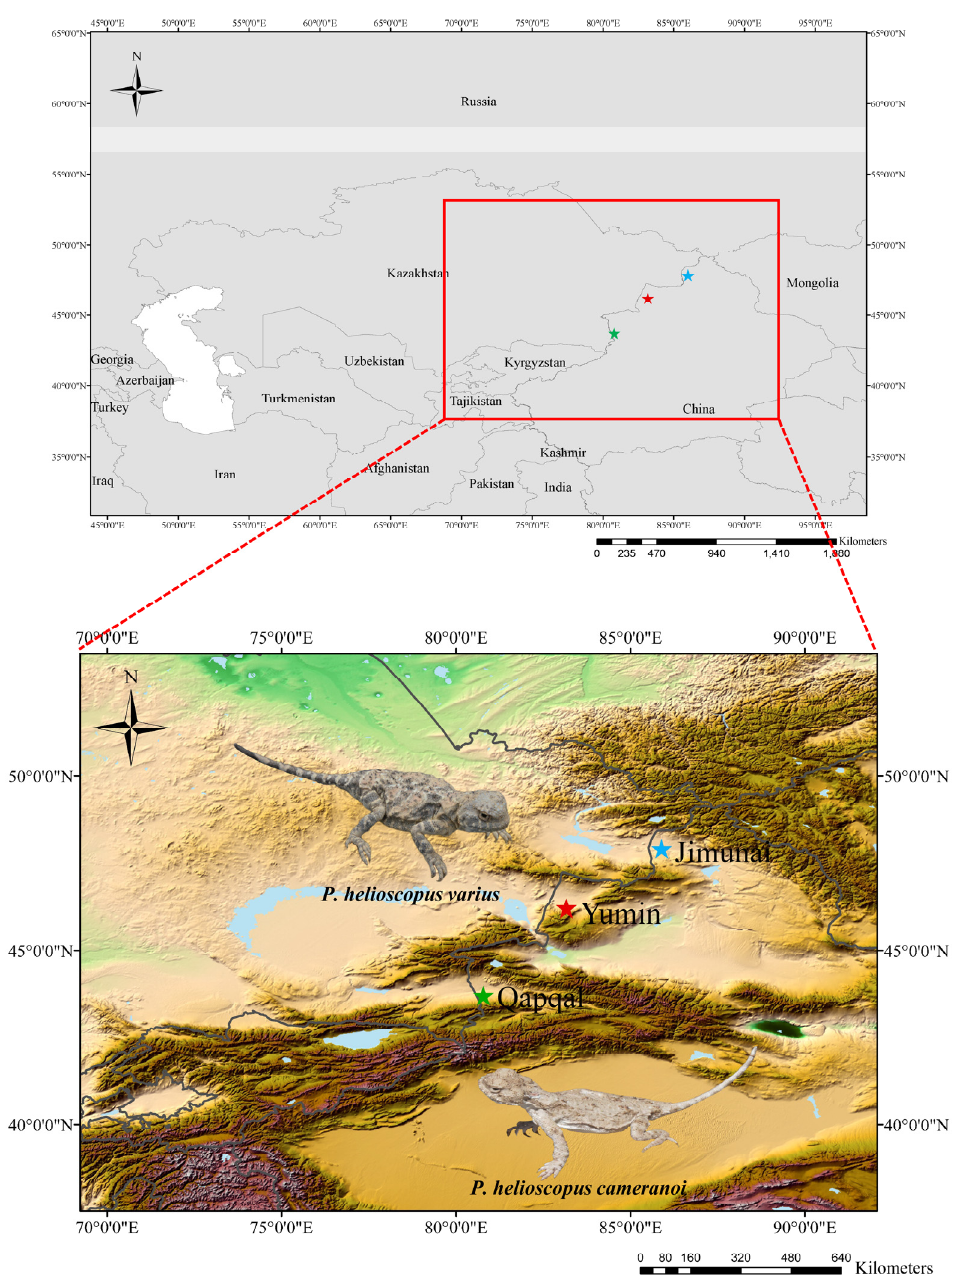
Figure 1. Sampling sites for the specimens of P. helioscopus in Xinjiang Uygur Autonomous Region, China.